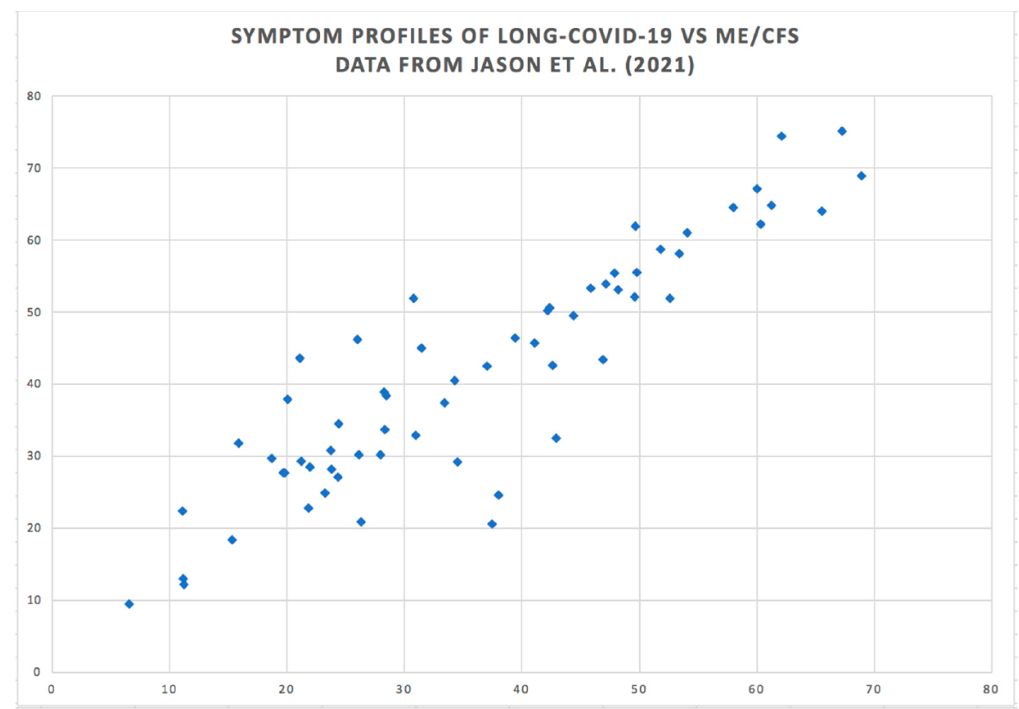
Figure 3. Correlation between ME/CFS and PASC symptom scores across 62 symptoms. Data from [15]. Public domain.